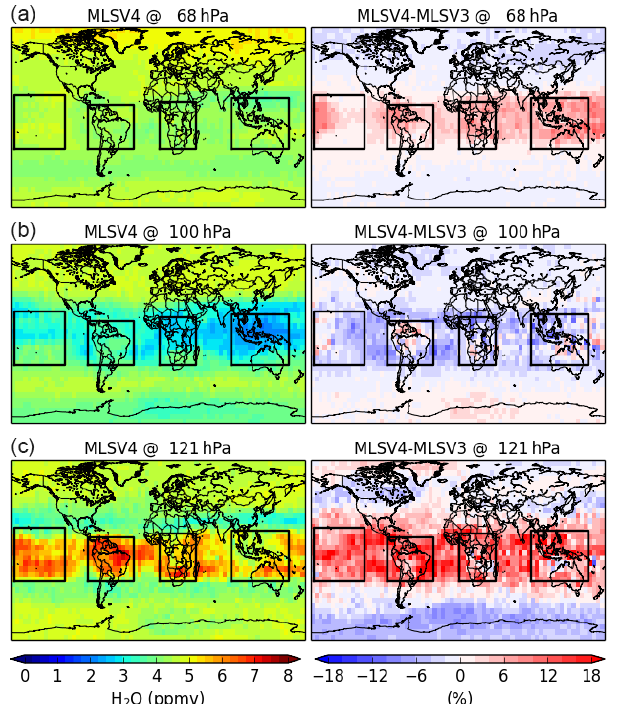
Figure 18. Monthly averaged H 2 O analyses in the MLS space in January 2012 using the MLS V4 data set (left) and relative differ- ence between the MLS analyses using V4 and V3 data sets (right) at 121hPa (c) , 100hPa (b) and 68hPa (a) .